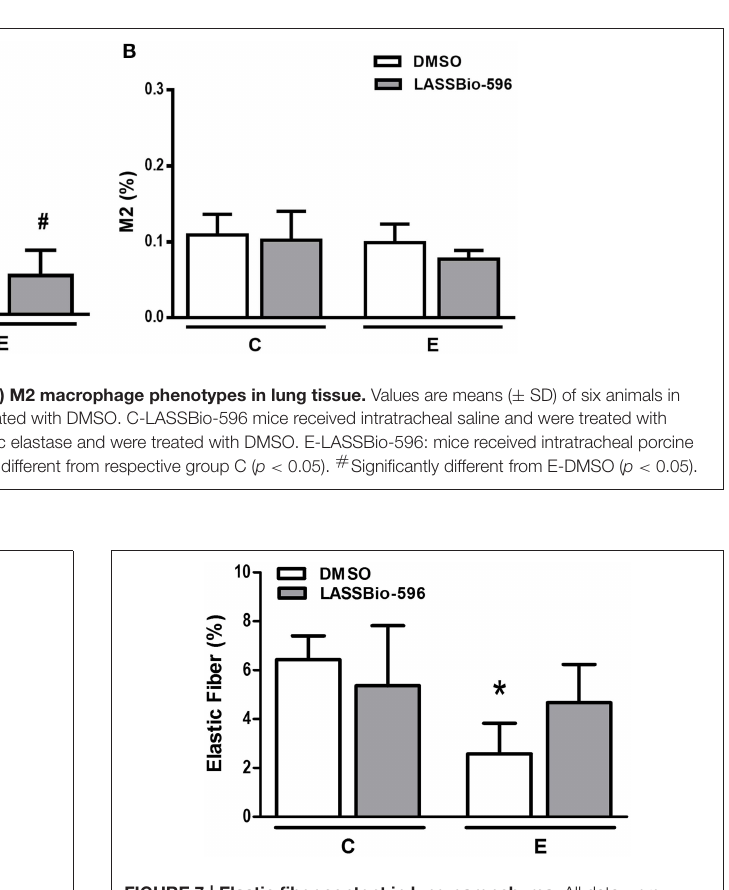
FIGURE 7 | Elastic fiber content in lung parenchyma. All data were collected in 10 random, non-coincident fields per mouse. Values are means ( ± SD) of six animals in each group. C-DMSO: mice received intratracheal saline and were treated with DMSO. C-LASSBio-596 mice received intratracheal saline and were treated with LASSBio-596. E-DMSO: mice received intratracheal porcine pancreatic elastase and were treated with DMSO. E-LASSBio-596: mice received intratracheal porcine pancreatic elastase and were treated with LASSBio-596. * Significantly different from respective group C ( p < 0.05